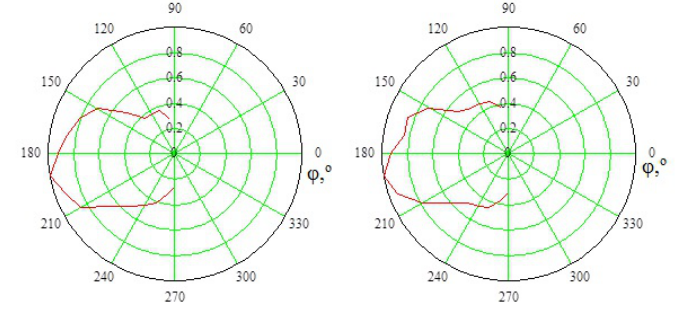
Figure 7. Directional diagram of UWB antennas of the “Snail” type at frequencies of 8 and 9